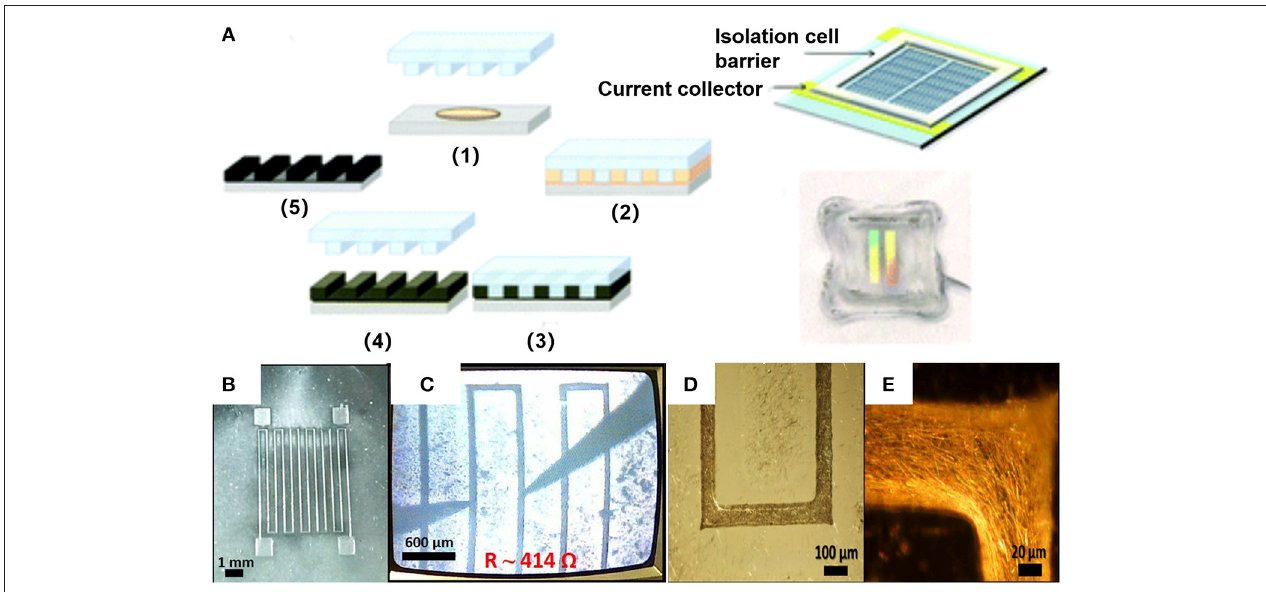
FIGURE 9 | (A) Schematic diagram of the electrodes utilized soft lithography method (Lochmann et al., 2018). Reproduced with the permission of 2018 Royal Society of Chemistry. (B) The optical images of fabricated electrodes (B) Optical images of flexible conductive electrodes. (C) Measurement of conductive trace. Optical images in bright field mode and dark field mode shown in (D,E) , respectively ( Martínez et al., 2016). Reproduced with the permission of 2016 IOP Publishing Ltd.